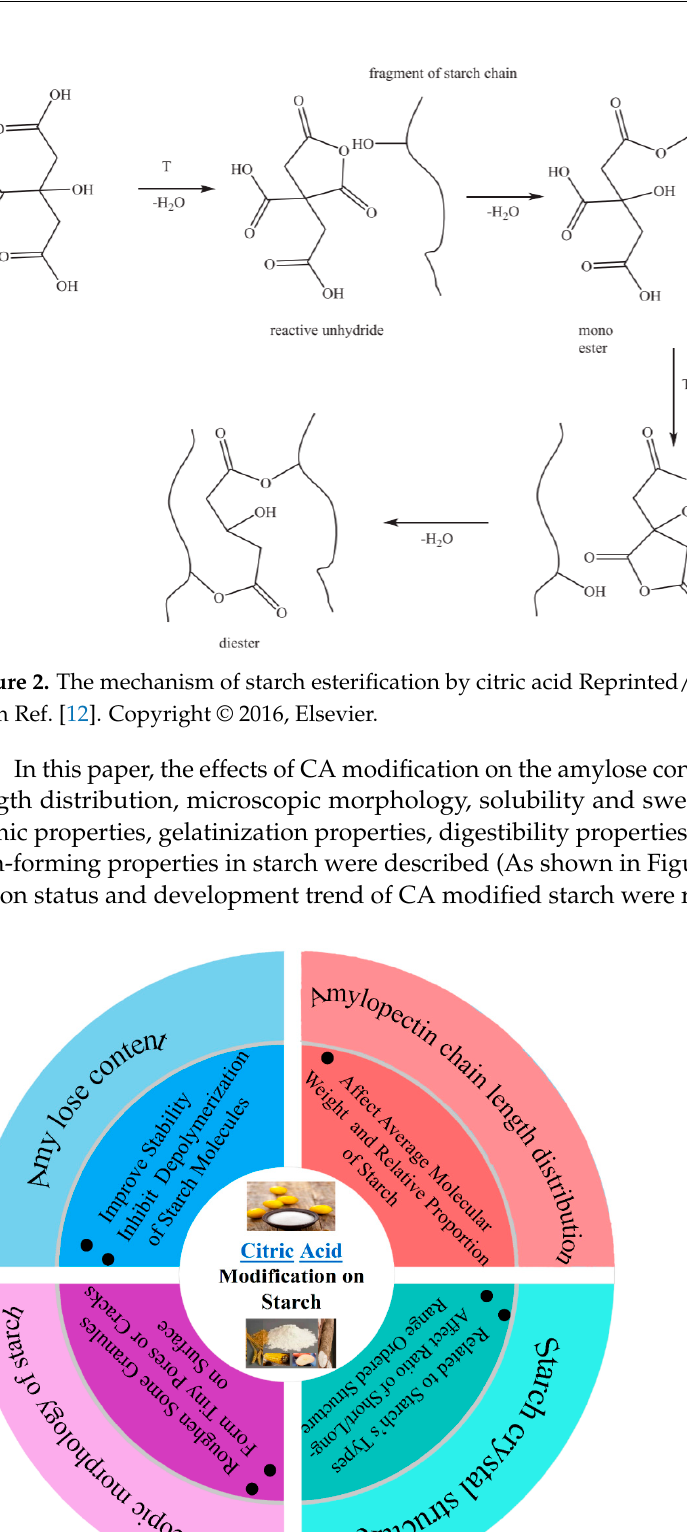
Figure 4. The effect of CA modification on the physical and chemical properties of starch and the application of CA-modified starch. 2. The Effect of CA Modification on the Starch Composition and Structure 2.1. Amylose Content